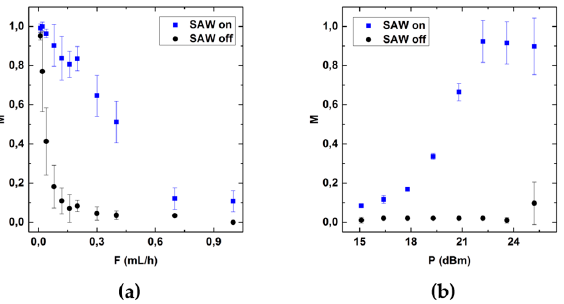
Figure 3. ( a ) Mixing quality as a function of the flowrate F ; ( b ) Mixing quality as a function of SAW power P . For P > 21 dBm sufficient mixing is achieved. The data point and error bars represent the mean and the standard deviation respectively of at least three experiments.